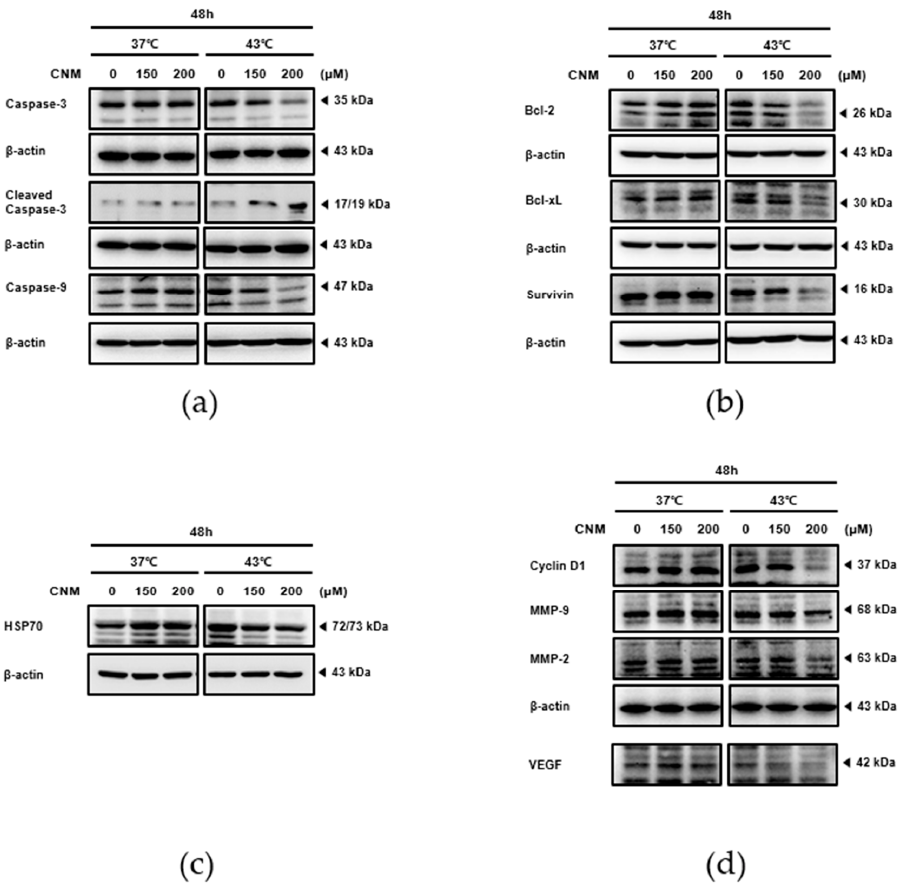
Figure 3. Effect of CNM and hyperthermia combination therapy on the protein levels of apoptosis and survival markers in A549 cells. A549 cells were treated with CNM (0, 150 or 200 μ M) with or without hyperthermia and incubated for 24 h. Whole-cell extracts were prepared, then equal concentrations of lysates were analyzed by Western blot analysis. Protein expression of ( a ) caspase-3, caspase-9, ( b ) Bcl-2, Bcl-xL, Survivin, ( c ) HSP70, ( d ) Cyclin D1, VEGF, MMP-2 and MMP-9 was measured using Western blot assays. β -actin was used as a loading control. Representative blots are